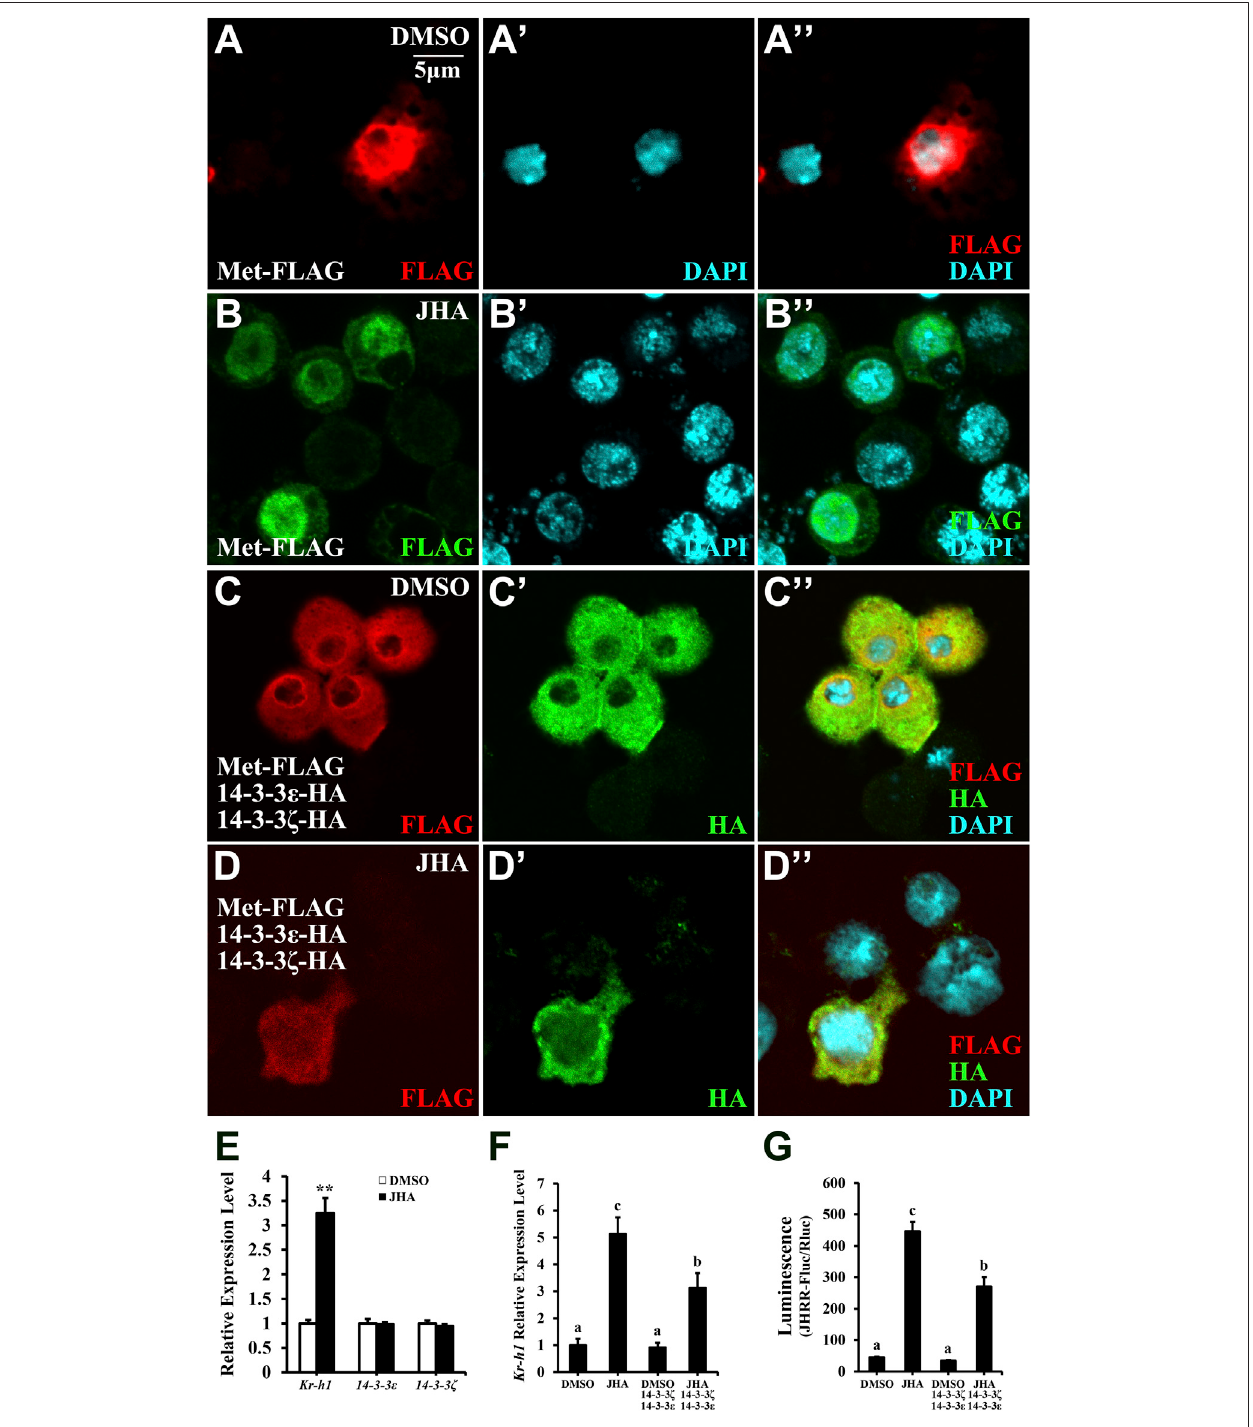
FIGURE 7 | 14-3-3 proteins suppress JH signaling activity via sequestrating Met in the cytoplasm. (A – D ’’ ) Subcellular localization of Met-FLAG or 14-3-3 proteins inKccellsaftera10 μ MJHAtreatmentfor1 h.FLAGandHAantibodieswereusedforimmunohistochemistry,DMSOwasservedasanegativecontrol. (E) EffectofJHA on the expression level of 14-3-3 ε and 14-3-3 ζ at 2 h after the treatments. Kr-h1 was used a positive control. ** p < 0.01 (Student ’ s t-test). (F,G) Effects of 14-3-3 overexpressiononKr-h1mRNAlevel (F) andluciferaseactivity (G) drivenbyJHRRinKccellsat2 haftera10 μ MJHAtreatment.Differentlettersindicatesigni fi cant differences using one-way ANOVA followed by Duncan multiple comparisons